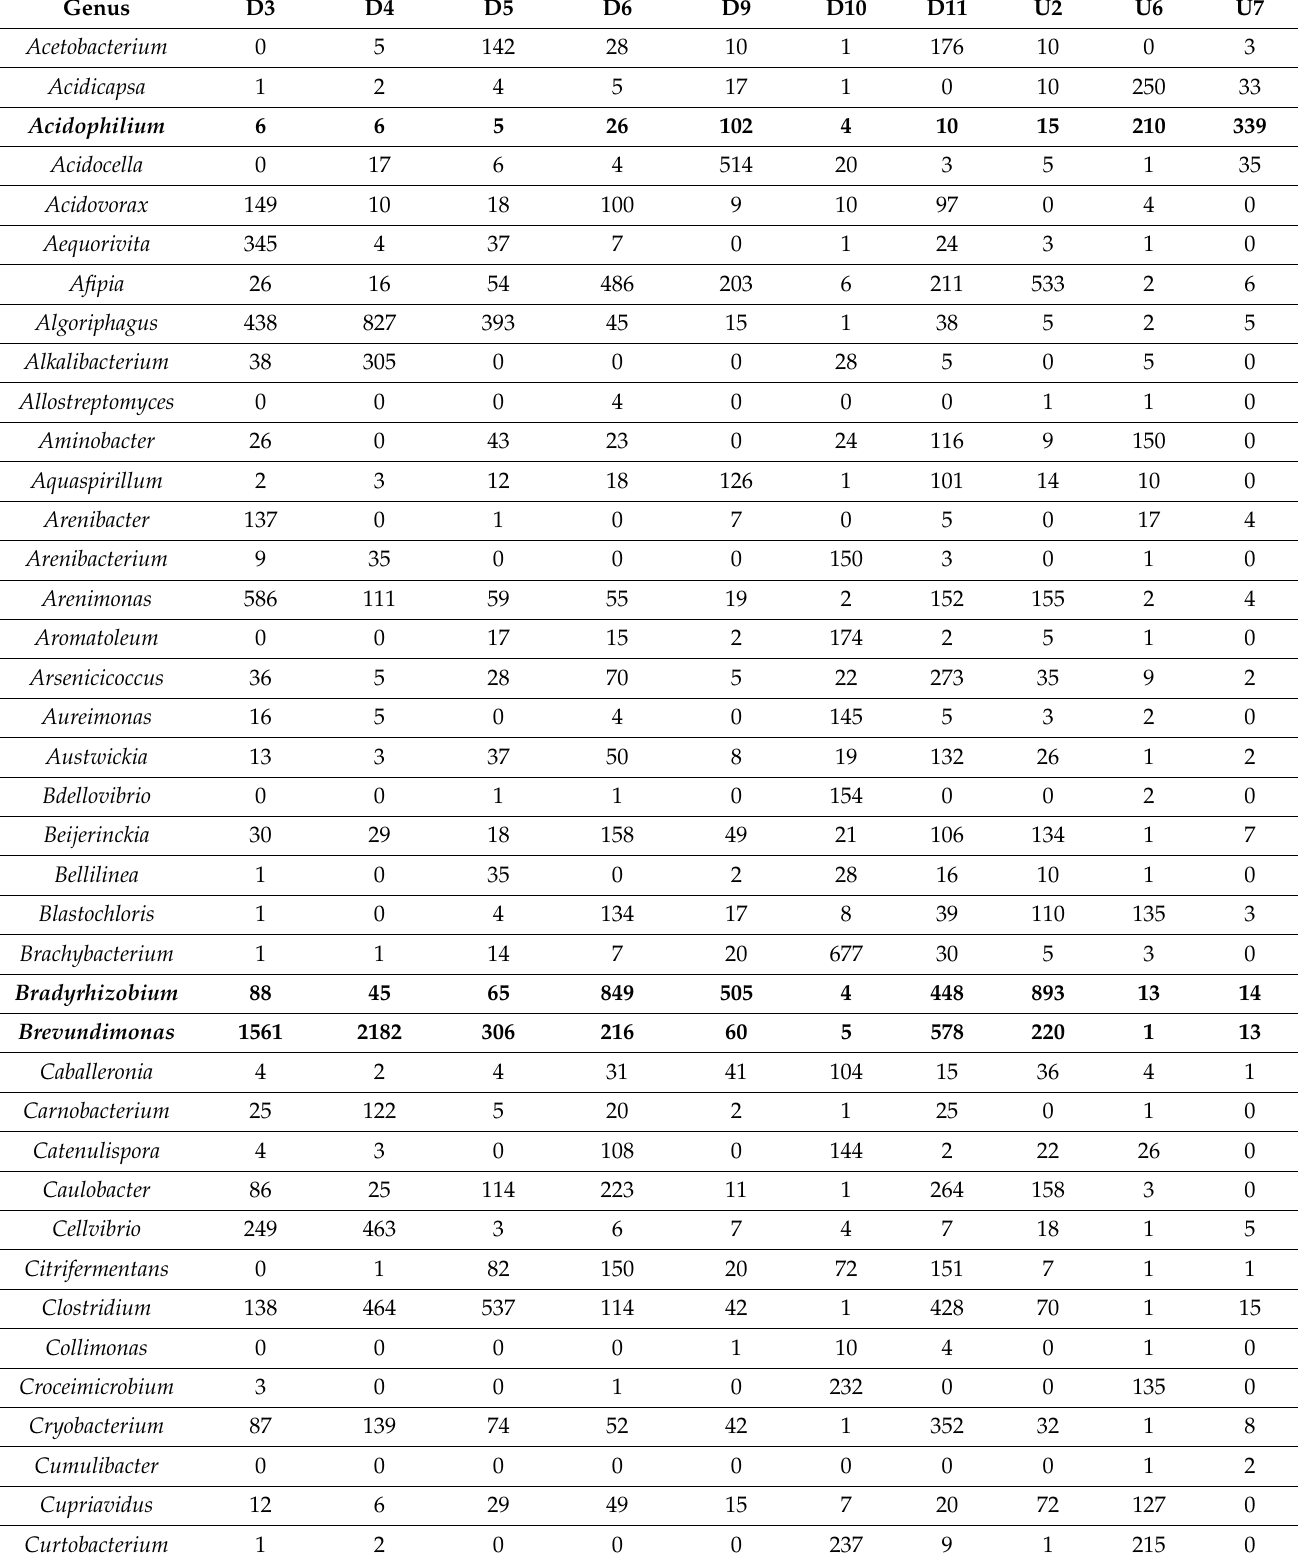
Table 4. Sequence number of each genus across each of the sites (only genera including at least one category above >100 sequences at a site were included). The genera in bold were present in the top four most common sequences in at least one of the